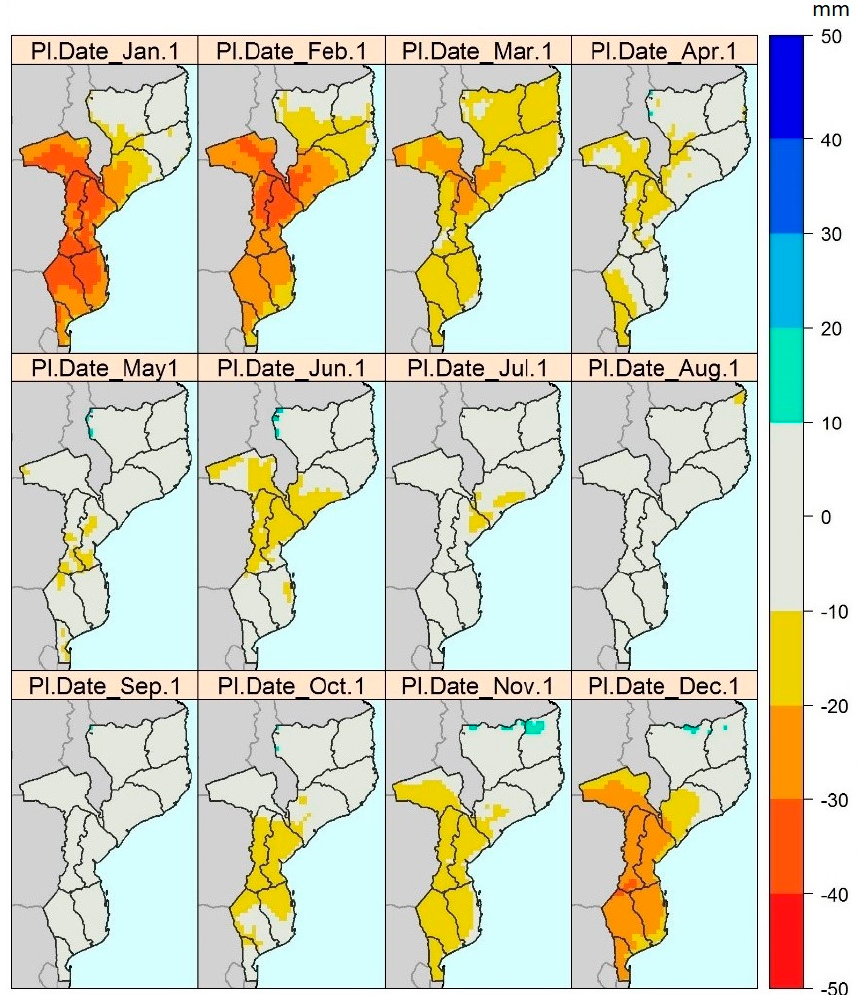
Figure 6. Spatial and temporal of deviation for La Niña of tomato crop total water requirement (mm) for Mozambique for a generic variety with 90-day growing cycle planted in the first day of each month.